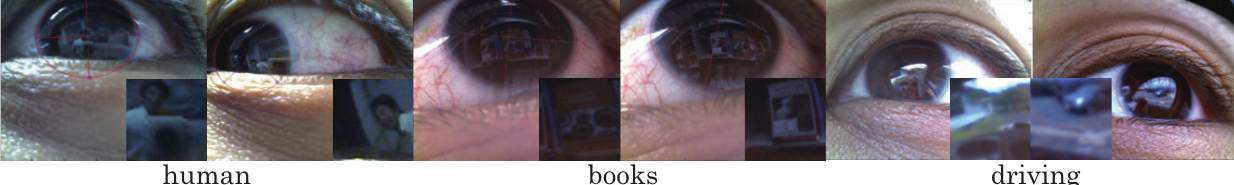
Figure 20 . Result obtained after extracting the focused object based on the point-of-regard in various situations.